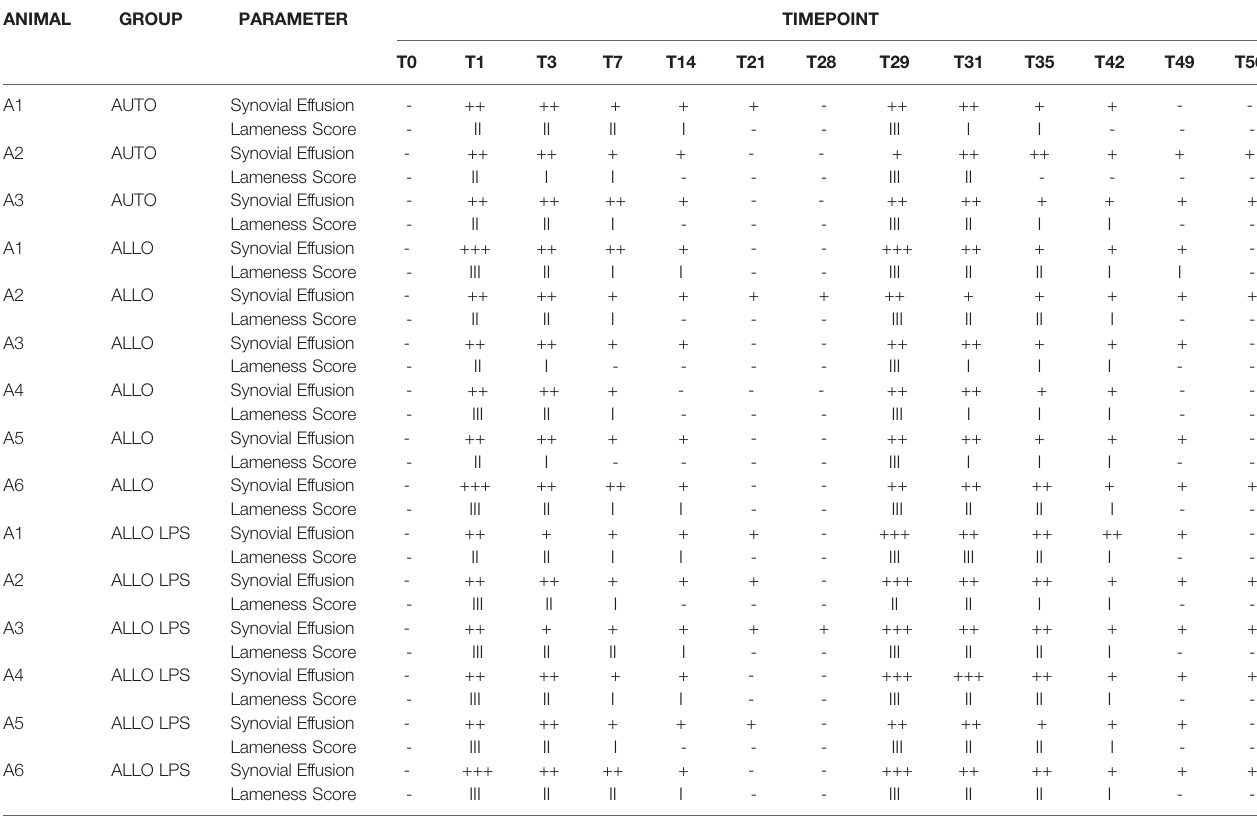
TABLE 1 | Clinical scores of synovial effusion and lameness grade. ANIMAL